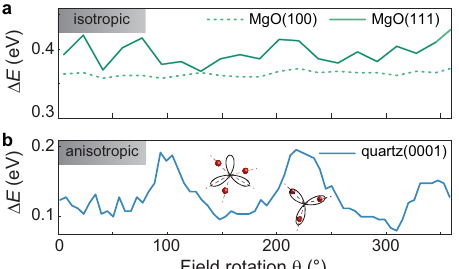
Fig. 5 Chirality-mediated band shifts. a , b Band shifts as a function of fi eld rotation for MgO ( a ) and quartz ( b ). The orientation-independent energy splitting in MgO suggests that the chirality originates from spin-polarized surface